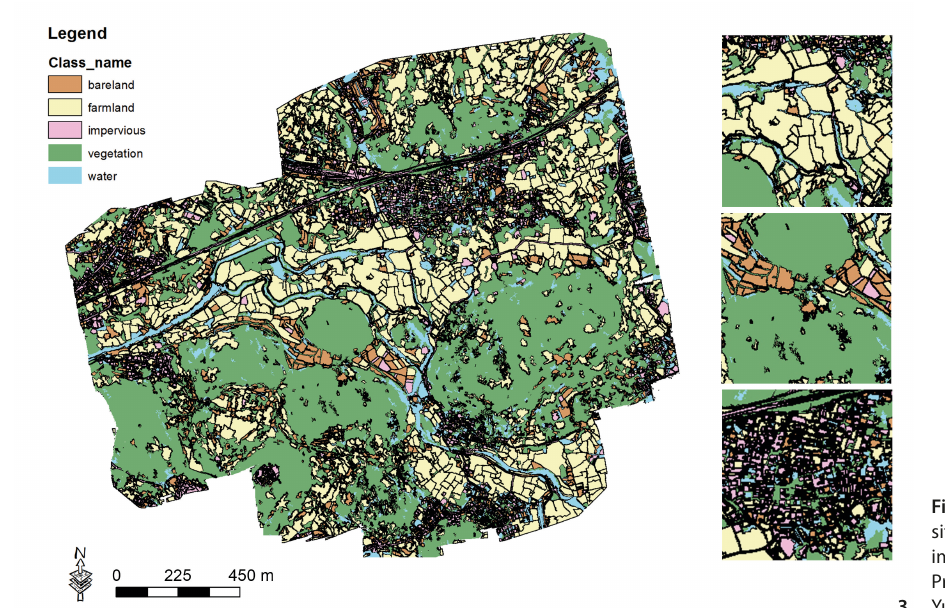
Figure 3 Landscape elements clas- sification based on multispectral image, Baojuatun Village, Guizhou Province (Source: Yujie Cao and Yuan Zhou).